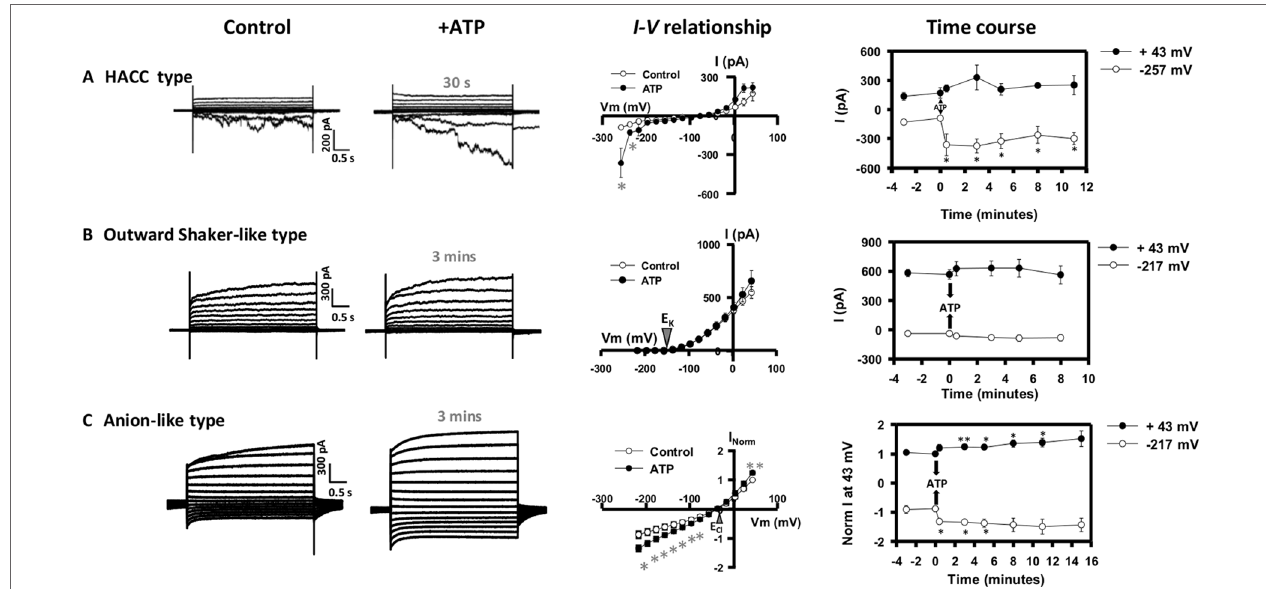
FIGURE 1 | Effect of extracellular adenosine 5 ′ -triphosphate (eATP) on diverse plasma membrane (PM) conductances from the root elongation zone epidermis. Protoplasts were isolated and used in whole-cell patch clamp recordings as described previously (Wang et al., 2018). Origin of the protoplasts was confirmed with the N9093 epidermal-specific green fluorescent protein (GFP) reporter line (Diatloff et al., 2004). This configuration measures populations of channels. Plasma membrane potential was held at −137 mV prior to a stepwise voltage protocol of 20 mV increments. Whole-cell currents were recorded in a bath solution containing (mM) 20 CaCl2, 0.1 KCl, and 5 MES-Tris, at pH 5.6. Pipette solution comprised (mM) 40 K-gluconate, 10 KCl, 0.4 CaCl2, 1 BAPTA, and 2 MES-Tris, at pH 7.2. Osmolarity of both solutions was adjusted to 280–290 mOsm with d -sorbitol. Representative current traces of (A) the hyperpolarization activated calcium channel (HACC) conductance, (B) the outward Shaker-like conductance, and (C) the anion conductance under control and eATP conditions (300 µM) are shown in the left panel. Corresponding mean I–V relationships for control ( ○ ) and eATP ( ● ) treatments are shown in the central panel with time of treatment indicated. The right panel presents the time course of eATP-activated outward currents at +43 mV ( ● ) and inward currents at −257 mV/−217 mV ( ○ ) for each type of conductance. Data are mean ± SE (n = 4 in A , 5 in B , and 4 in C ). Negative current is net cation influx or anion efflux. Positive current is net cation efflux or anion influx. Asterisks denote significant difference from control. * p < 0.05, ** p < 0.01 (Student’s t